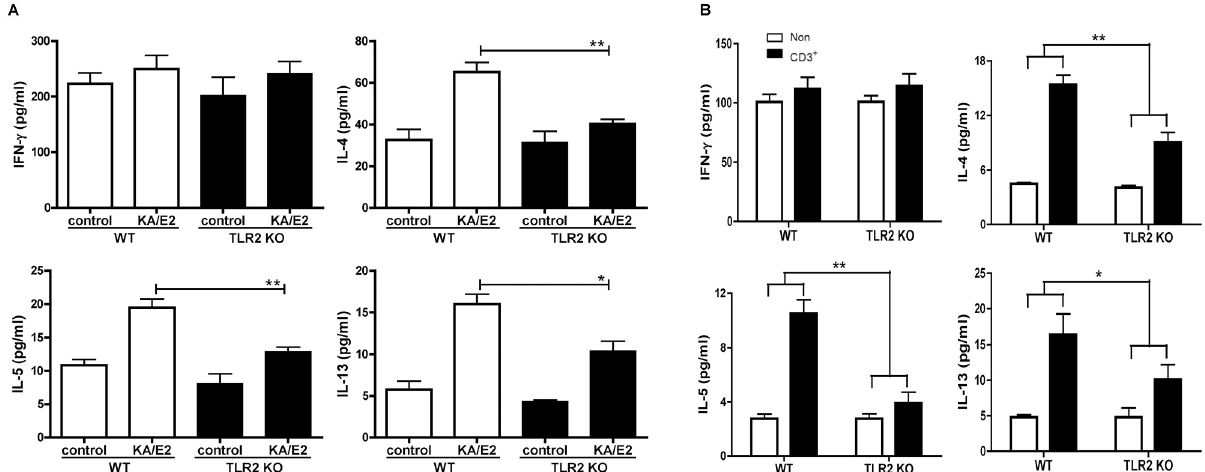
Fig 4. Comparison of the Th2 cytokine expression level after treatment with KA/E2 in WT and TLR2 KO mice. Th2 related cytokine (IL-4, IL-5, and IL-13) concentrations in the BALF (A) and culture supernatants of CD3-stimulated lymphocytes from LLN (B) were determined using ELISA. The plates were read at 450 nm on a standard ELISA reader, VICTOR 3 (Each p -value was determined using t -test methods compared to the control) (n = 5 mice/group, 3 independent experiments, � p < 0.05, �� p < 0.01).